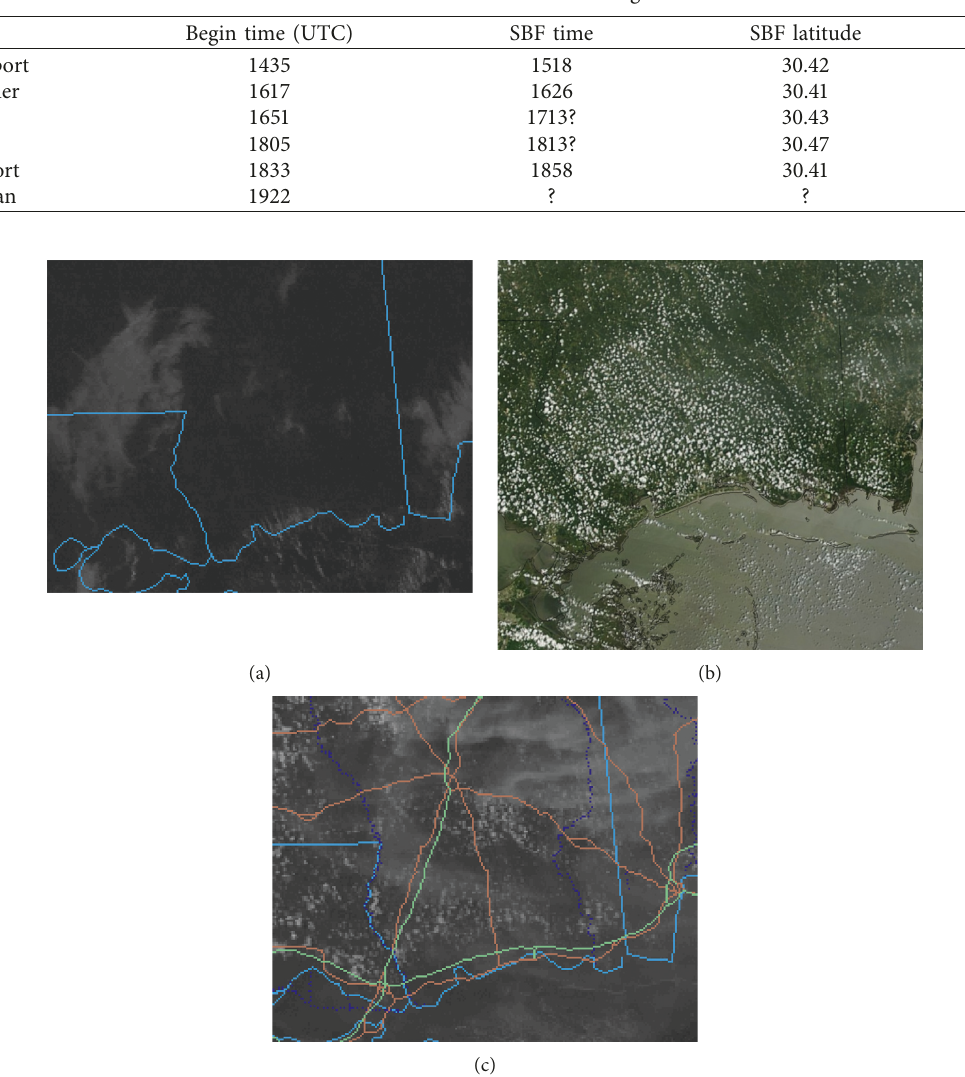
Figure 11: Visible imagery on 10 August 2015. (a) GOES at 1315 UTC (0815 CDT). (b) MODIS Terra at 1650 UTC (1150 CDT). (c) GOES at 1945 UTC (1445 CDT).